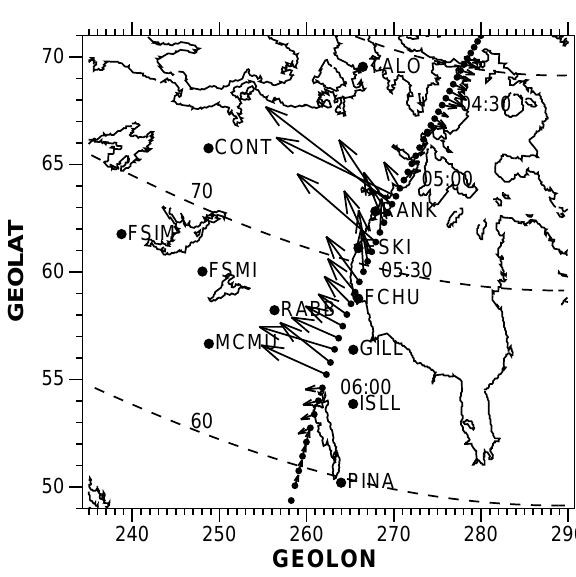
Fig. 6. Polar footpoint trajectory over CANOPUS magnetometer network for 25 April 1997, 4:00–6:30UT. Equivalent current vec- tors of the magnetometer nearest to the footpoint is shown by arrows (arbitrary scale). Circles of constant invariant latitude are shown as dashed lines. UT times are shown on the right side of the trajectory.